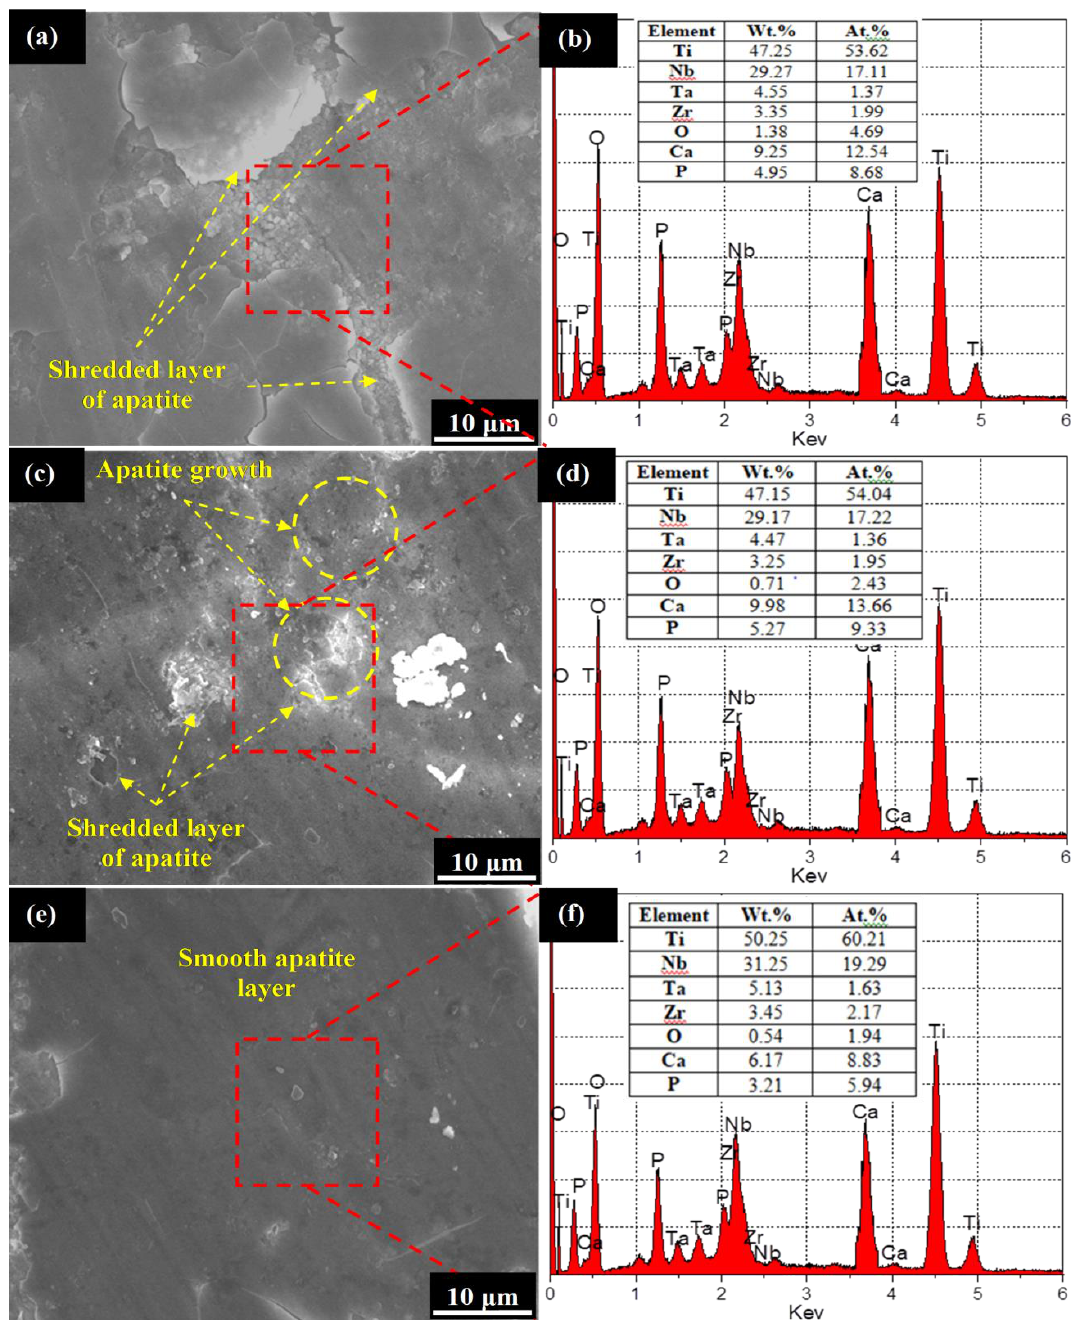
Figure 6. Corroded morphology and EDS spectrum of finished surface: ( a , b ) 600 rpm, ( c , d ) 1200 rpm, and ( e , f ) 900 rpm.